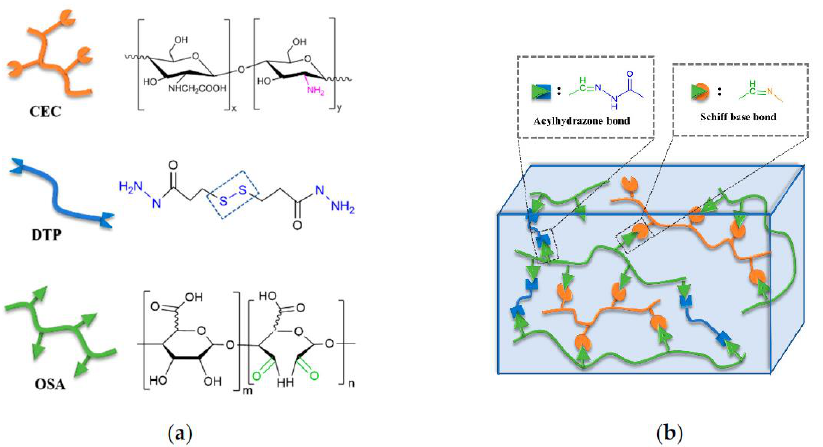
Figure 4. ( a ) Structures and illustrations of carboxymethyl chitosan (CMC), 3,3′-dithiopropionic acid dihydrazide (DTP) and oxidized alginate (OSA); ( b ) schematic of crosslinking strategy (modified from [80]).